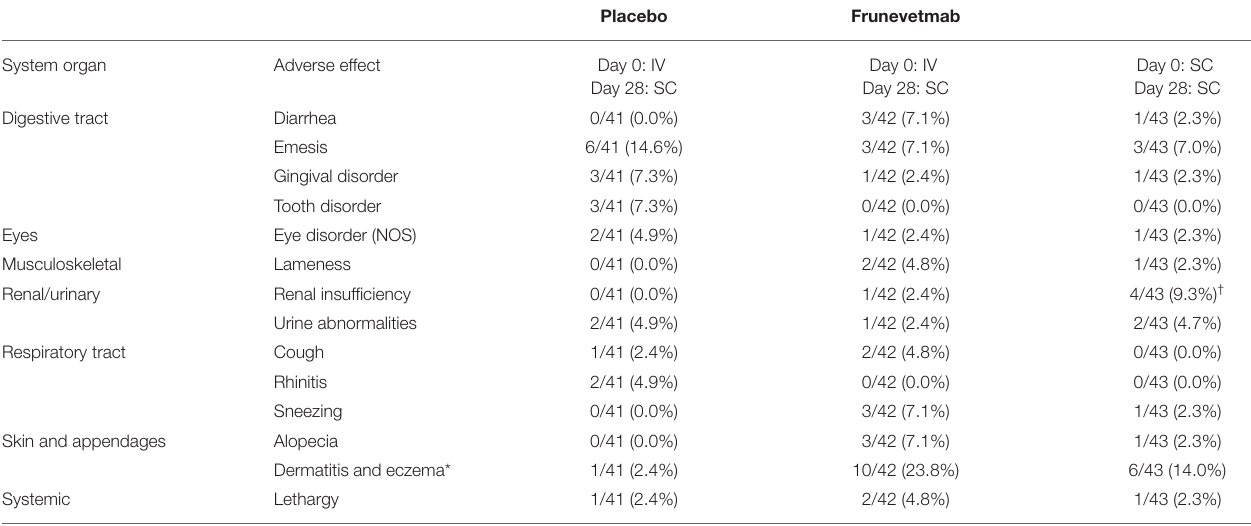
TABLE 5 | Adverse events reported in two or more cats in any treatment group.